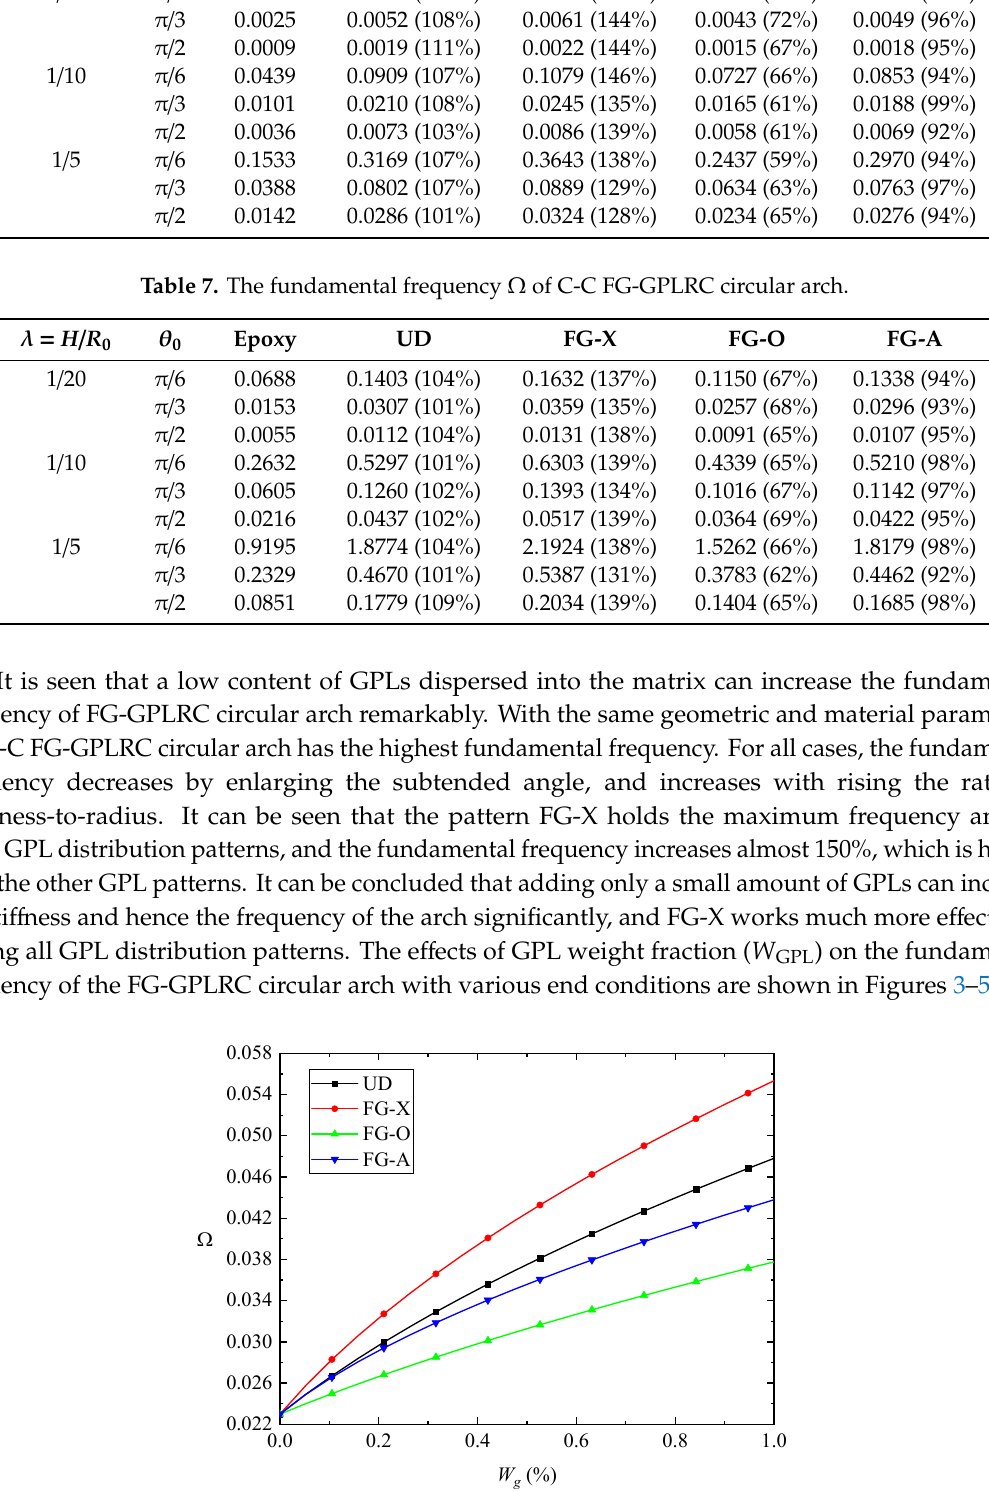
Table 6. The fundamental frequency Ω of C-F FG-GPLRC circular arch.